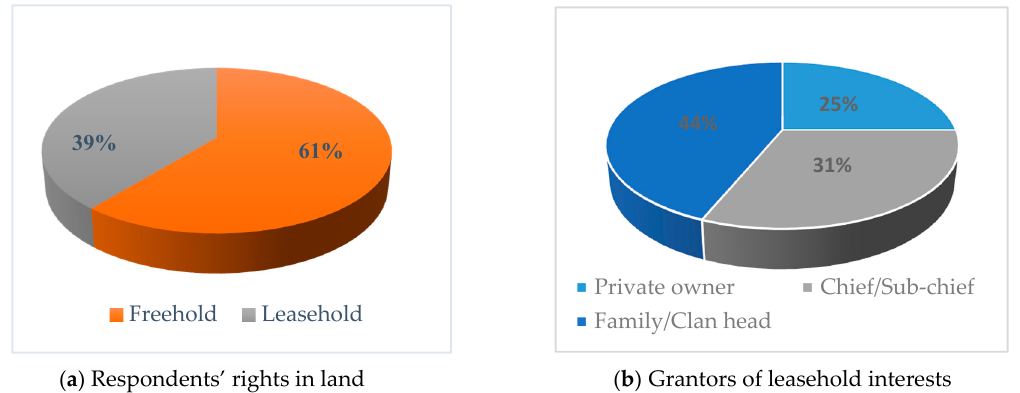
Figure 2. Respondents’ rights in land ( a ) and grantors’ leasehold interest ( b ) (source: Authors). The results show that family heads have granted most of the leasehold interest in